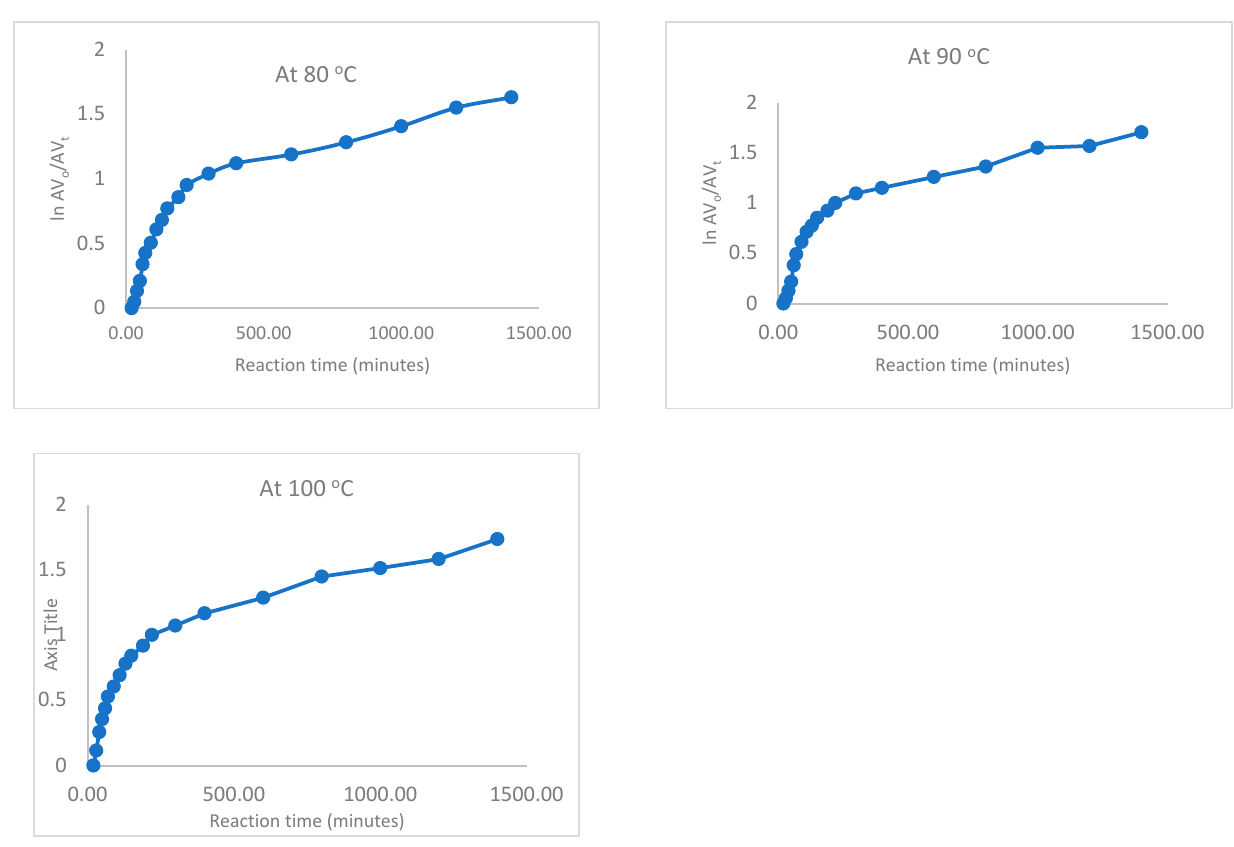
Figure 3. lnAV o /AV t versus time at 80 °C, 90 °C, and 100 °C in the presence of benzimidazole as a catalyst.